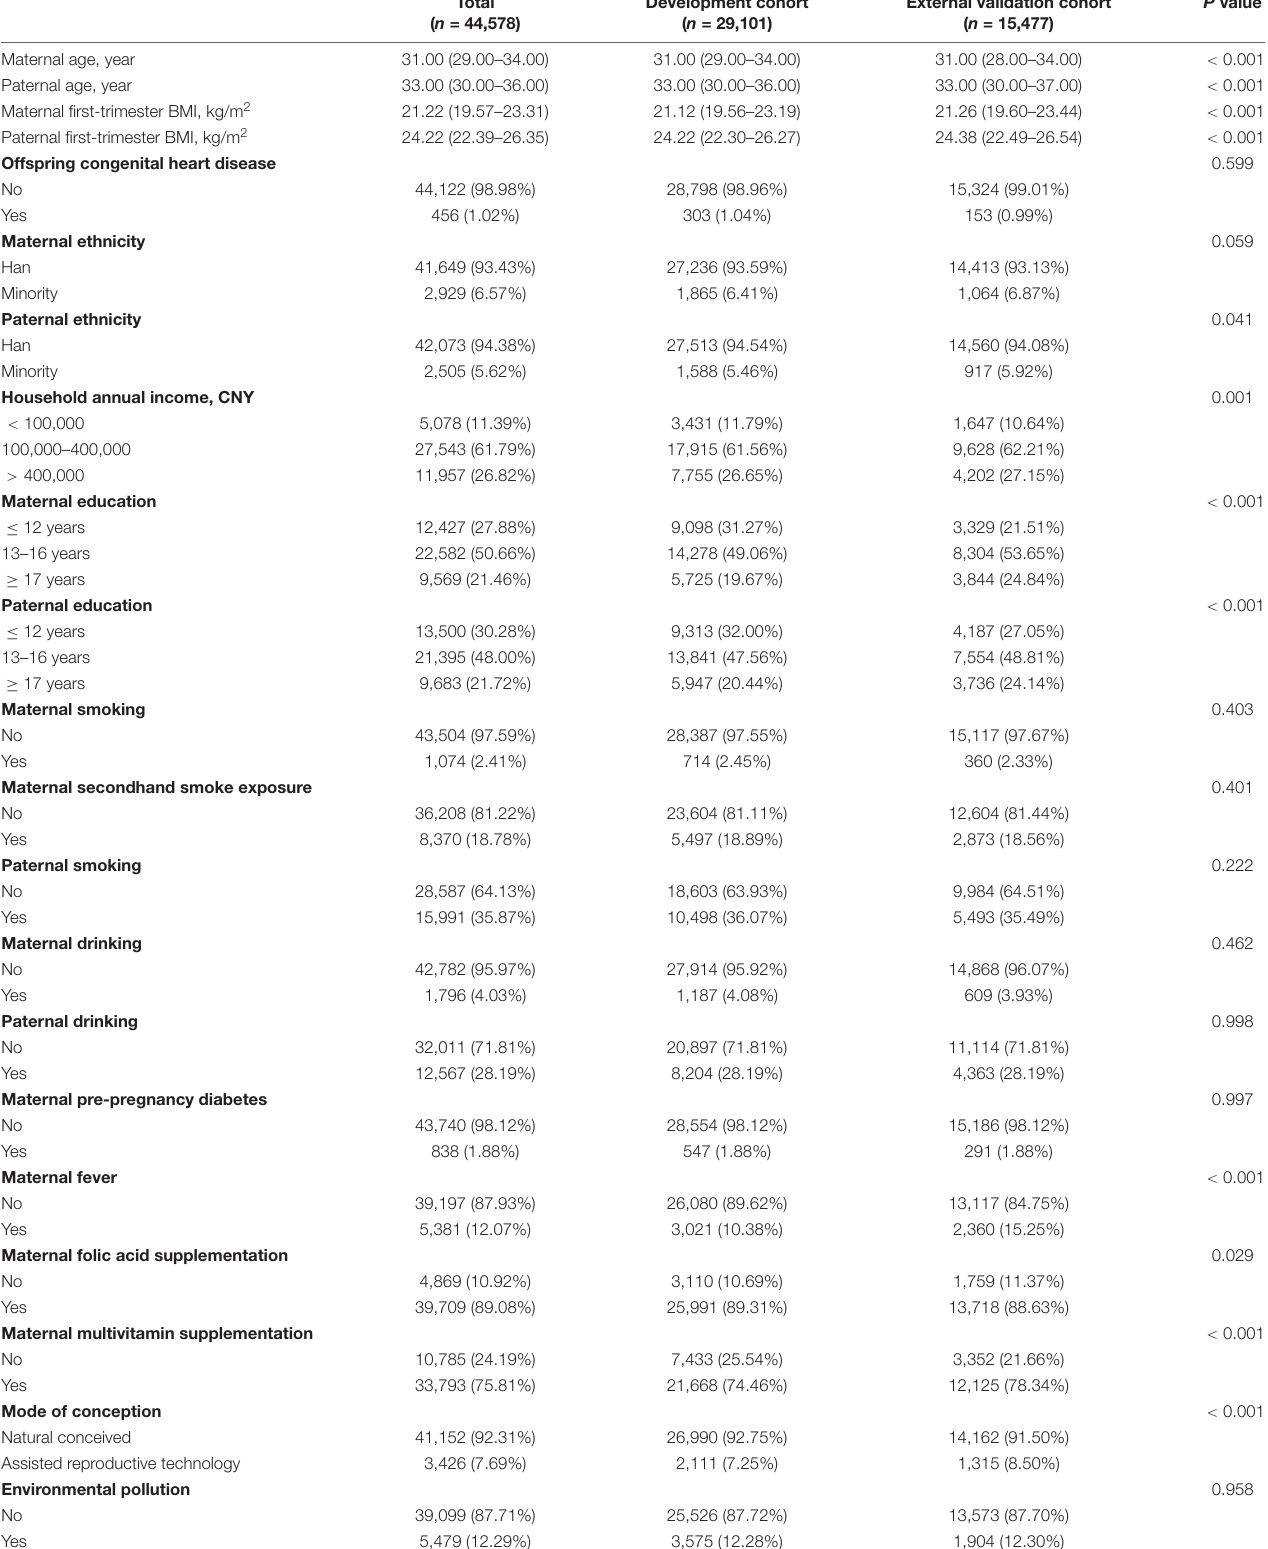
Results in table: Median (Q1-Q3)/N (%). CNY, China Yuan; BMI, body mass index.